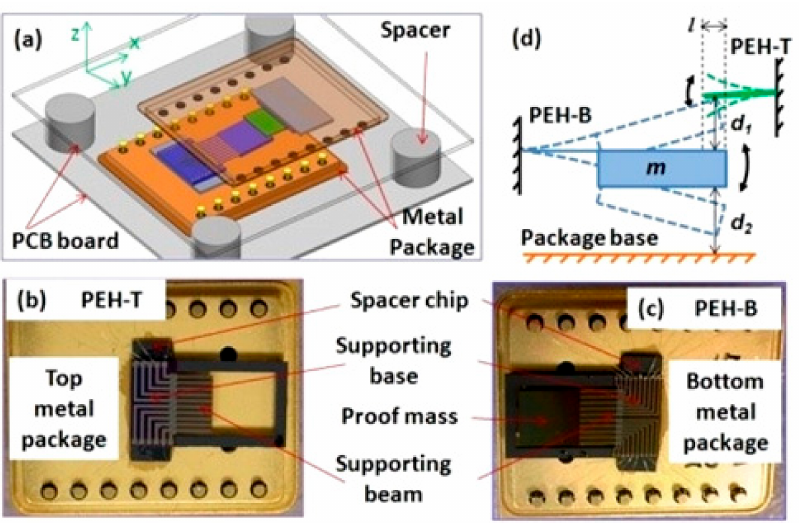
Figure 11. ( a ) Device configuration of an impact-based PEH system. ( b ) Operation mechanism of the impact-based PEH system. ( c ) Top view of the bottom PEH device. ( d ) Top view of the top PEH device